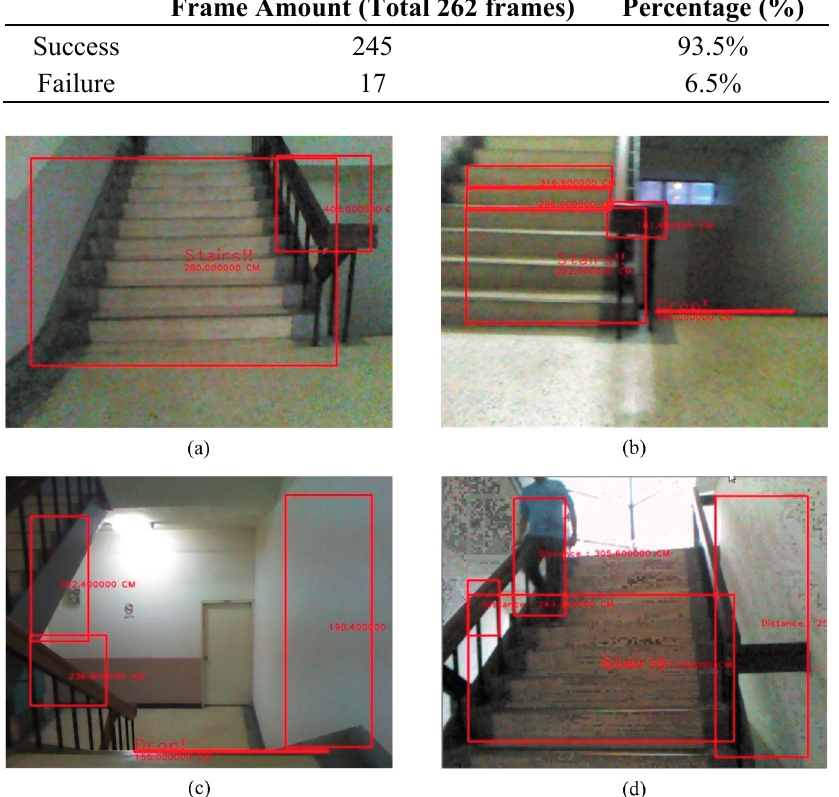
Figure 24. The detection of an obstacle indoors under sufficient light. ( a ) Rising stairs; ( b ) Rising and descending stairs; ( c ) Obstacle and descending stairs; ( d ) Obstacle and descending stairs.